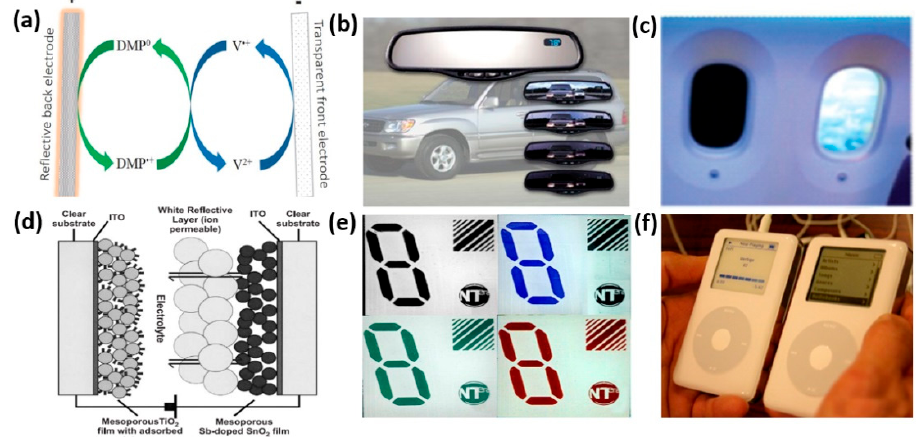
Figure 18. ( a ) Schematic representation of the redox cycles occurring within the Gentex automatic dimming rear view mirror. ( b ) A photograph of Gentex auto dimming mirror device. ( c ) A photograph of electrochromic windows on the Boeing 787 Dreamliner. ( d ) Cross-section structure of a NanoChromics display device. ( e ) A photograph of colored NanoChromics devices. ( f ) A photograph of ipod prototypes with NanoChromics display (left) and LCD display (right). Reproduced with permission from Elsevier B.V. [127].